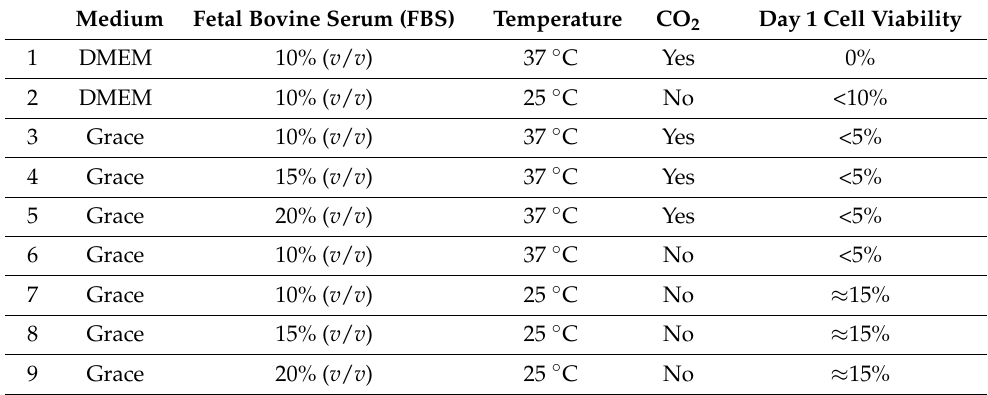
Table 1. Test of different culture conditions (media, FBS supplementation, temperature, and CO 2 presence) during the cell culture optimization process and the effect of each variable on cell viability. An approximation of the cell viability was determined by examining the appearance of the cells on Day 1 of cell culture in a series of 3–5 different